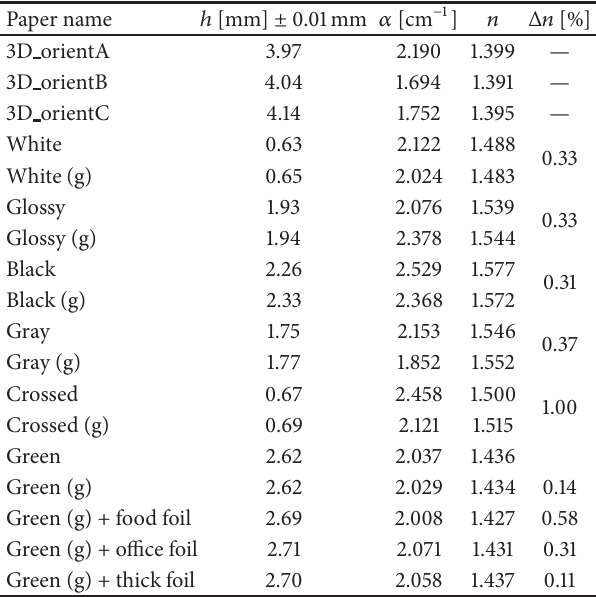
Table 1: Values of refractive indices and absorption coefficients for frequency 0.3THz. (g) corresponds to samples with